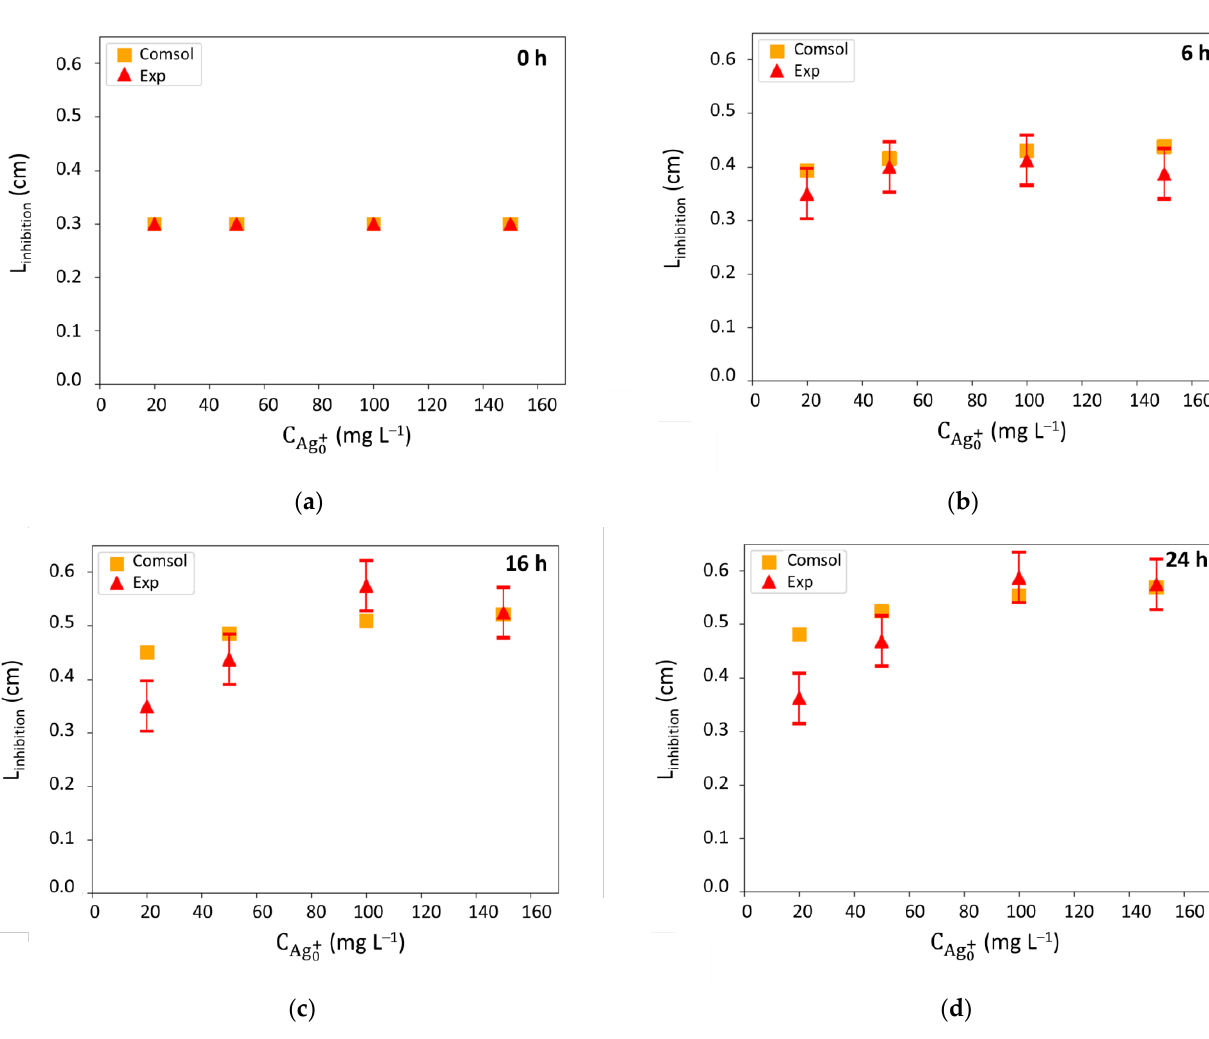
Figure 11. Concentration profiles after 24 h of contact (full lines: Ag + , i.e., C Ag+ ; dotted lines: E.coli bacteria, i.e., N). Blue curve: C Ag0+ = 20 mg L −1 ; red curve: C Ag0+ = 50 mg L −1 ; green curve: C Ag0+ = 100 mg L −1 ; yellow curve: C Ag0+ = 150 mg L −1 . The radius of the inhibition zone was defined as the smallest distance from the well center for which the E. coli concentration (N) was zero. After 24 h, Figure 11 shows that the bacterial concentration was zero up to a radius about 0.5 cm. In order to determine with precision the inhibition halos radii from the concentration profile of bacteria (Figure 11), a minimum of the curve giving N with time t (and thus with the r axis) was searched according to Equation (24). The solving of Equation (24) gave a silver concentration, which